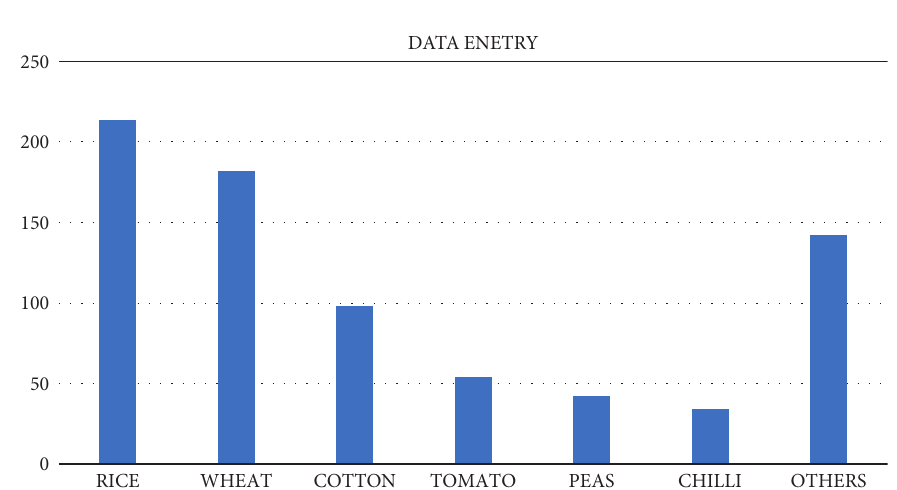
Figure 4: Proposed methodology approach.